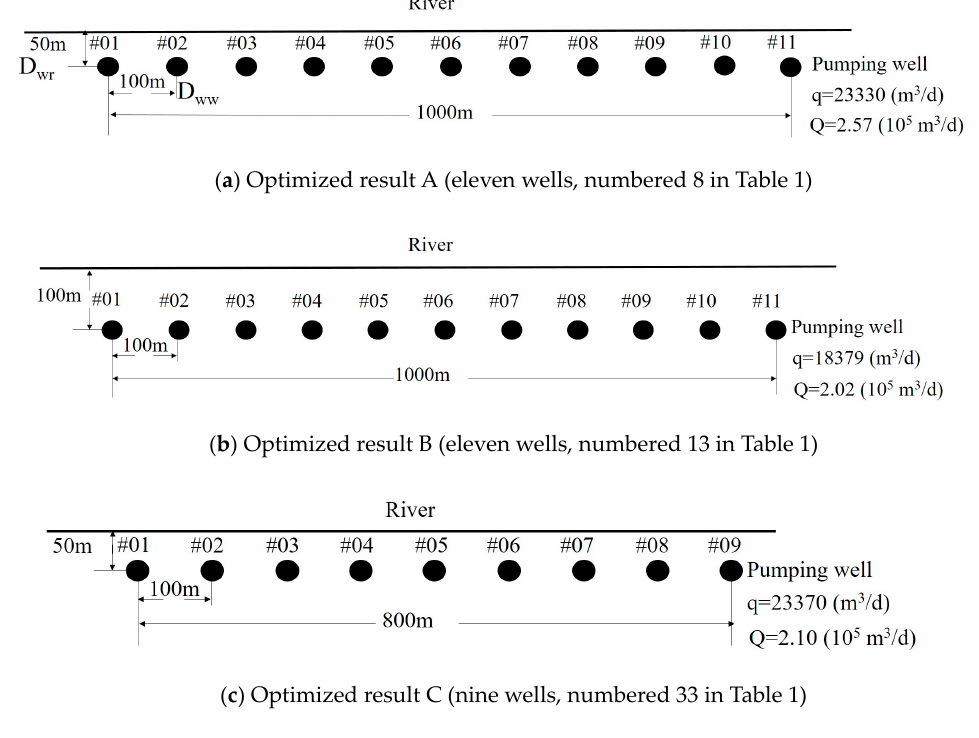
Figure 5. Schemes obtained from the fourth optimizing step.